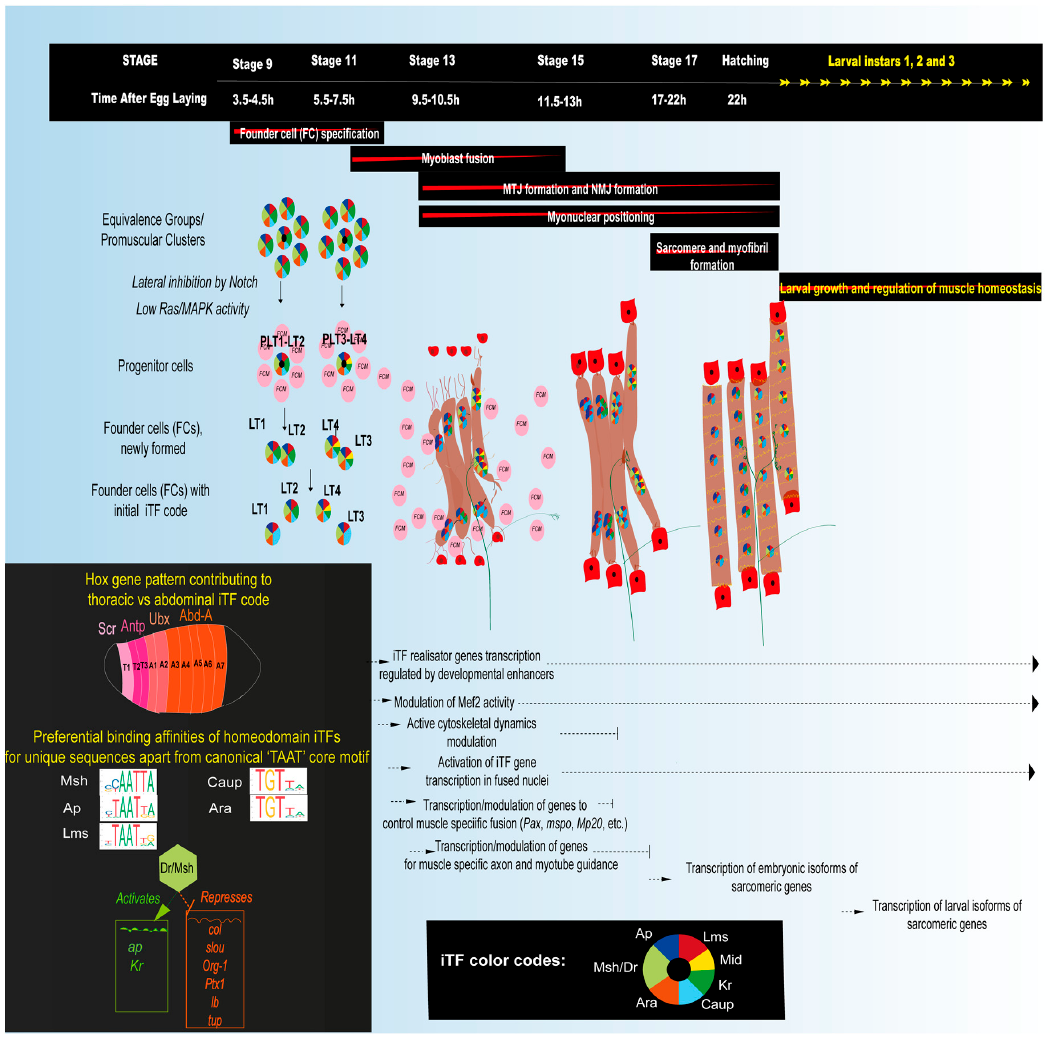
Figure 2. Spatial and temporal expression muscle identity transcription factors (iTFs) of the larval lateral transverse (LT) muscles. Sizes are not up to scale. Following the specification of progenitor cells by a lateral inhibition by Notch and low Ras / MAPK activity, founder cells (FCs) expressing muscle specific iTFs are specified for each LT muscle, LT1, LT2, LT3, and LT4 with a contribution from homeobox (Hox) genes to specify thoracic versus abdominal identities. Each iTF has preferential binding abilities to certain enhancers. The iTF expression is followed by the regulation of transcription and modulation of expression of their realisator genes which establish muscle identity over the course of development. The spatial and temporal expression of iTFs coupled with their modulation of realisator genes, which include generic muscle genes, in collaboration with Mef2 begs the question about their contribution to muscle homeostasis. Abbreviations: FCM: Fusion competent myoblasts; FC: Founder cells; LT: Lateral transverse muscles; iTF: Identity transcription